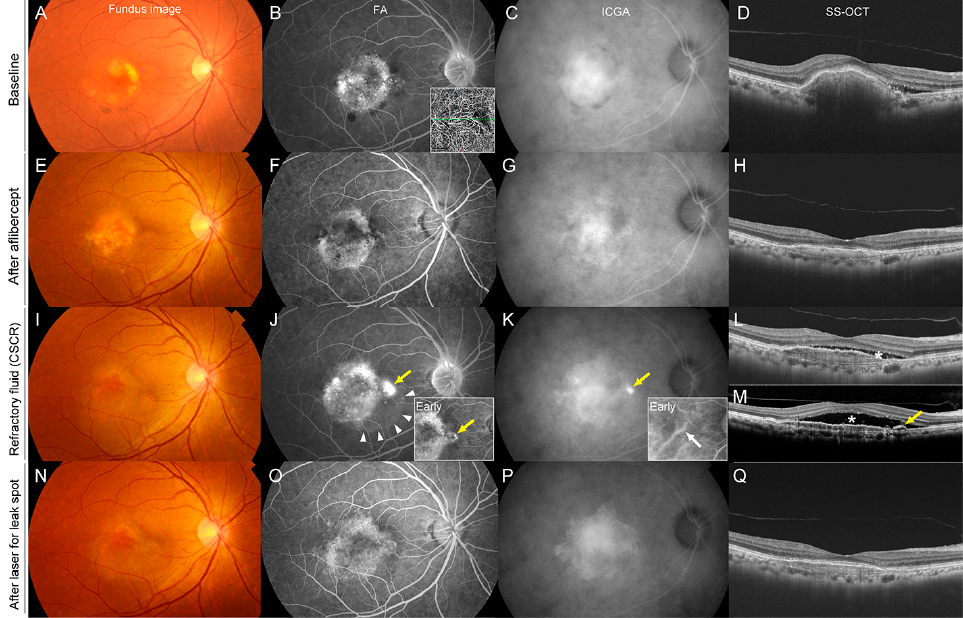
Figure 1. Refractory Age-related Macular Degeneration Due to Concurrent Central Serous Chori- oretinopathy in a 56-year-old Woman. Images are at baseline ( A – D ), after three consecutive intrav- itreal aflibercept treatments ( E – H ), at the time of the development of refractory subretinal fluid due to CSCR ( I – M ), and after laser treatment for leakage spot in CSCR ( N – Q ). ( A ) A color fundus photograph at baseline showed choroidal neovascularization (CNV) associated with age-related macular degeneration. ( B ) A late-phase fluorescein angiography (FA) showed leakage associated with CNV, and OCT angiography showed CNV. ( C ) A late-phase indocyanine green angiography (ICGA) showed a hyperfluorescence associated with CNV. ( D ) Swept-source optical coherence to- mography (SS-OCT) showed fibrovascular pigment epithelial detachment (PED) and subretinal fluid. ( E – H ) After three monthly consecutive intravitreal treatments with aflibercept, the height of the PED reduced and subretinal fluid disappeared. ( I – M ) At eight months, the FA showed a newly developed leakage spot adjacent to the CNV margin ( J , yellow arrow) and the area of serous retinal detachment (white arrowheads). ICGA revealed dilated choroidal vessels in the early phase (white arrow) and a hyperfluorescence corresponding to the leakage in the late phase ( K ). SS-OCT showed recurrence of the subretinal fluid ( L , asterisk). Despite additional intravitreal aflibercept, subretinal fluid increased further at nine months, indicating refractoriness to intravitreal aflibercept. SS-OCT slice at the leakage spot showed a small serous PED (arrow) corresponding to the leakage spot and underlying dilated choroidal vessels below the leakage spot. ( N – Q ) After laser photocoagulation to the leakage spot shown in ( J ), the subretinal fluid completely disappeared ( Q